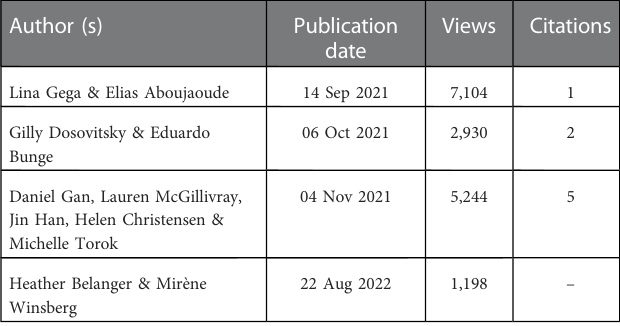
TABLE 1 Number of views and citations by 04 Jan 2023 of the articles included in the collection (authors appear in the order of publication